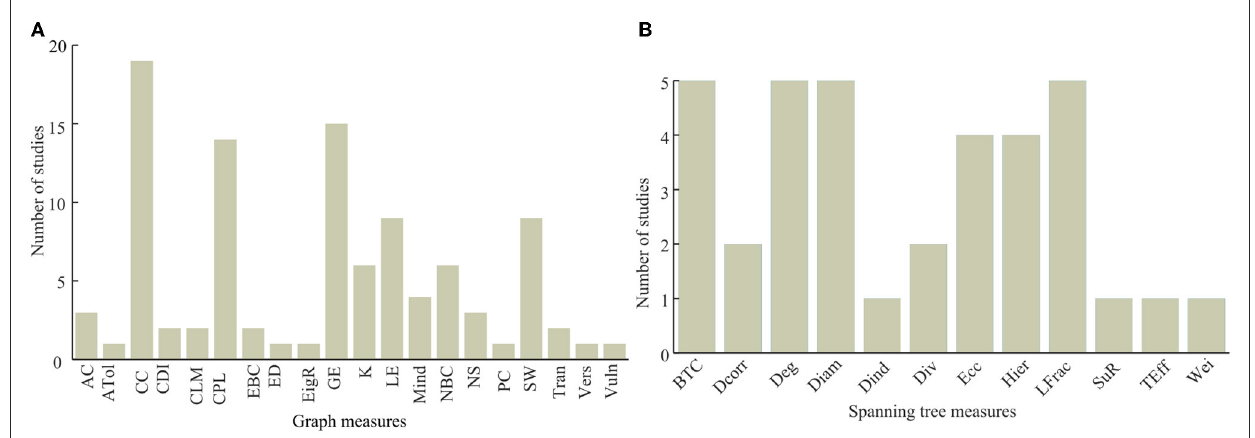
FIGURE7 Usage of graph theory measures with (A) being the usage of graph theory metrics and (B) being the usage of spanning tree metrics.